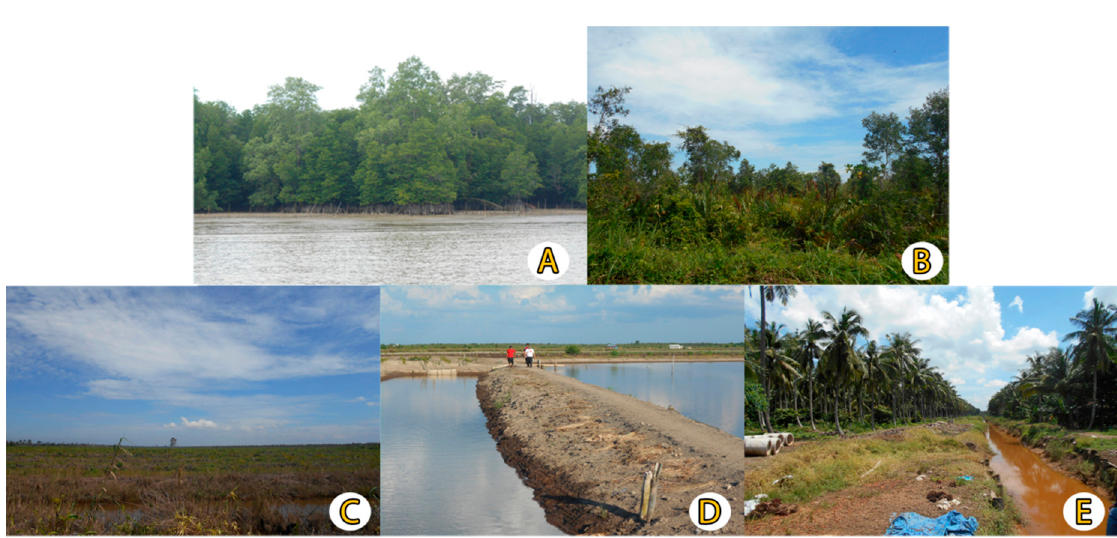
Figure 2. Conditions of land cover types in ATPF: ( A ) primary forest, ( B ) secondary forest, ( C ) open area, ( D ) fishpond, and ( E ) coconut plantation. Table 2. The coordinates of the ground check results using a Geographical Positioning System (GPS). No.